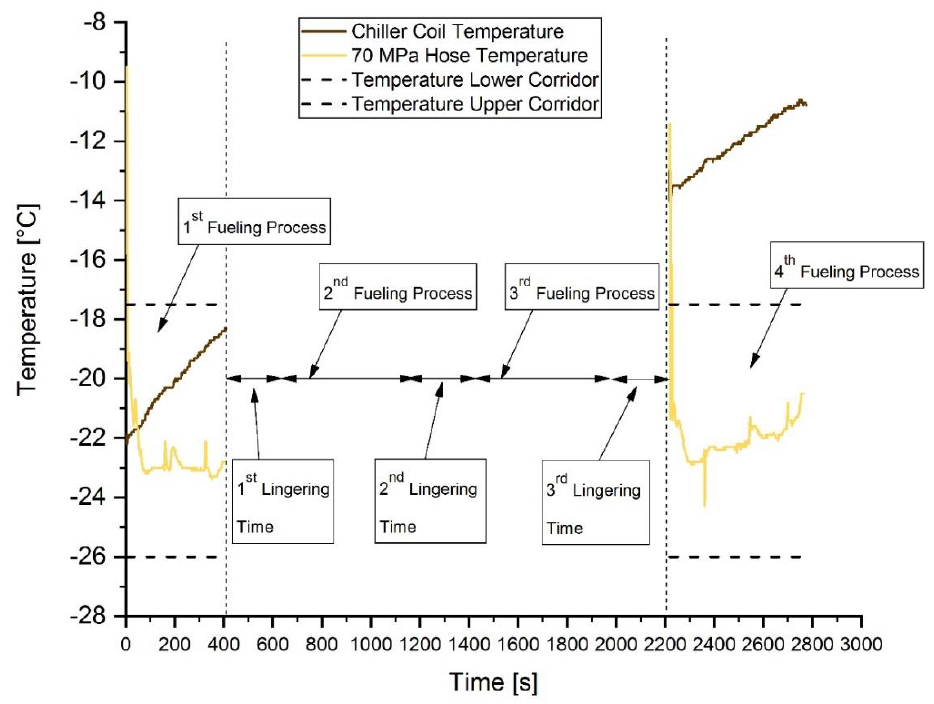
Figure 12. Four back-to-back refueling processes and temperature trend at the station. Reproduced with permission from [93], Elsevier, 2023.